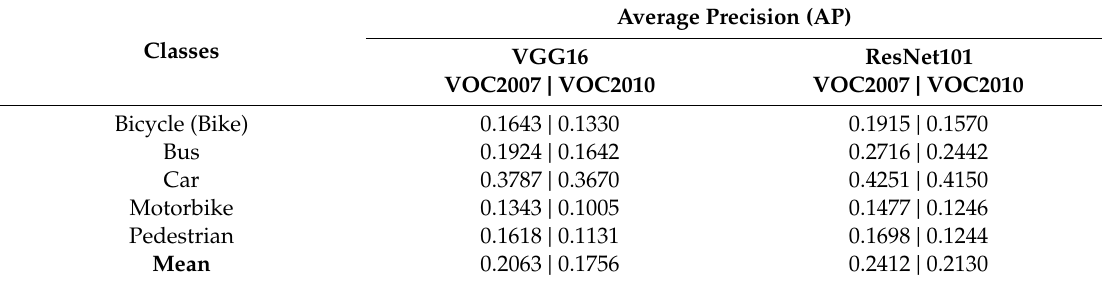
Table 1. Performance of common classes inferred by the models trained with PASCAL VOC 2007 [6] for our nighttime